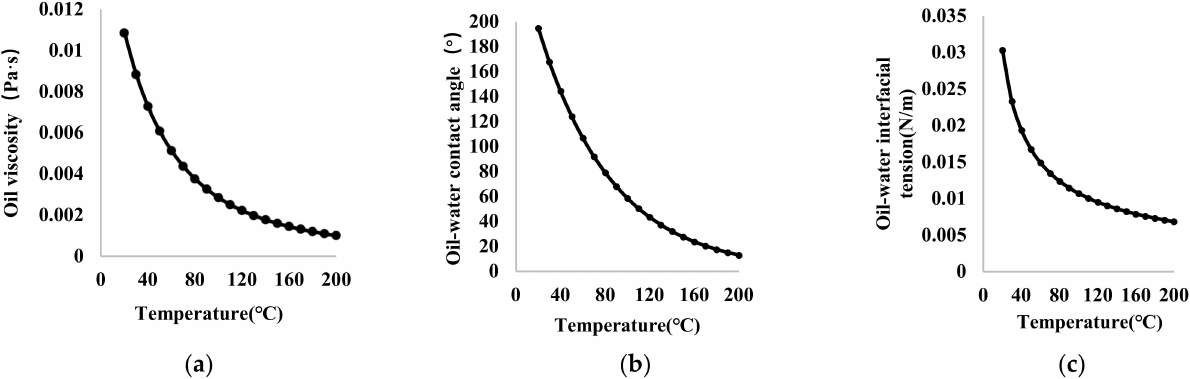
Figure 23. ( a ) Oil viscosity with different temperatures. ( b ) Oil-water contact angle with different temperatures. ( c ) Oil-water interfacial angle with different